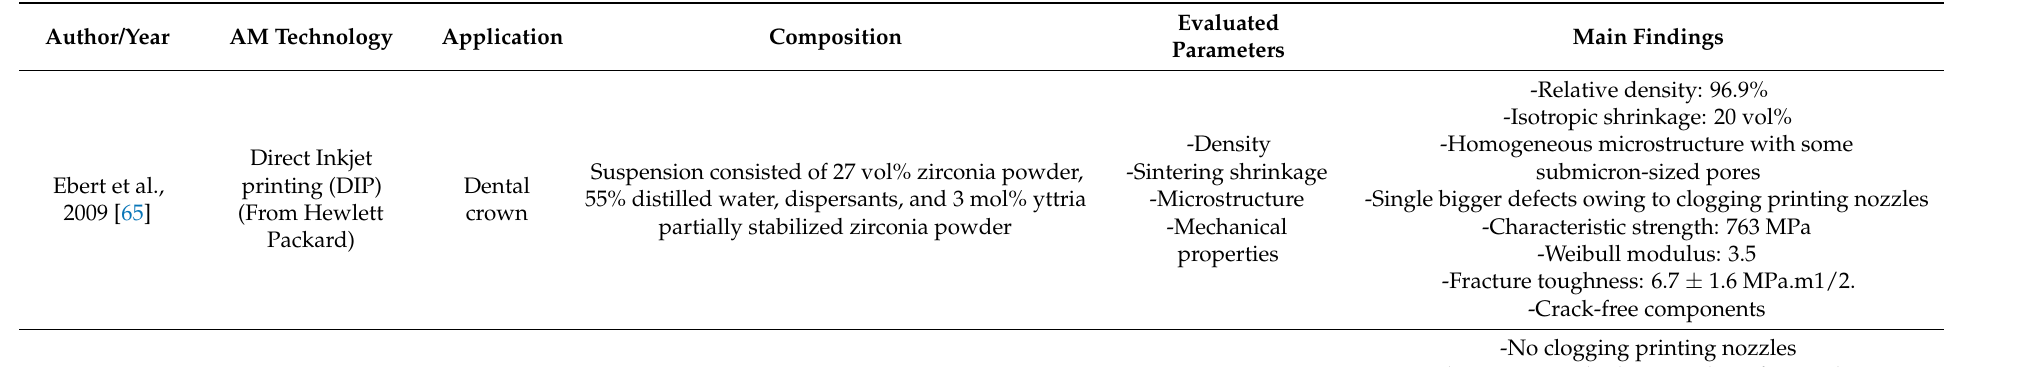
Table 1. Summary of studies using AM manufactured zirconia for the fabrication of dental